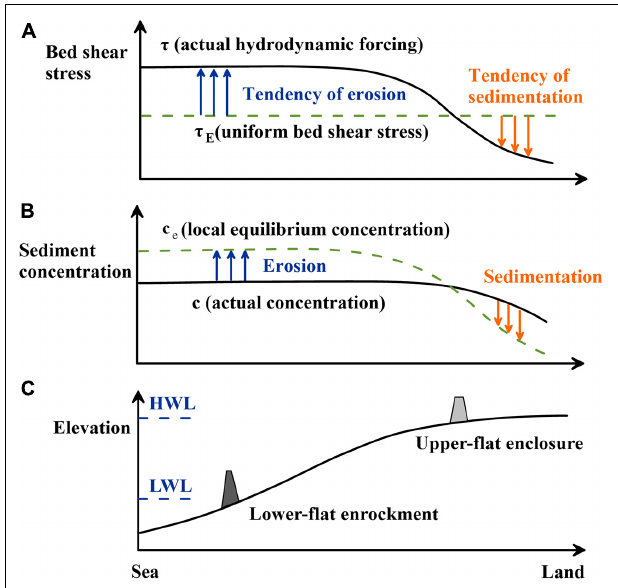
FIGURE 1 | The schematization of the DET-ESTMORF model (modified from Hu et al., 2015) and the two kinds of reclamation. (A) Cross-shore distributions of the actual bed shear stress τ and the equilibrium shear stress τ E , showing tendencies of morphological changes. (B) Cross-shore distributions of the actual concentration c and the local equilibrium concentration c e , the difference between which determines the actual morphological changes. (C) An illustration exhibiting upper-flat enclosure and lower-flat